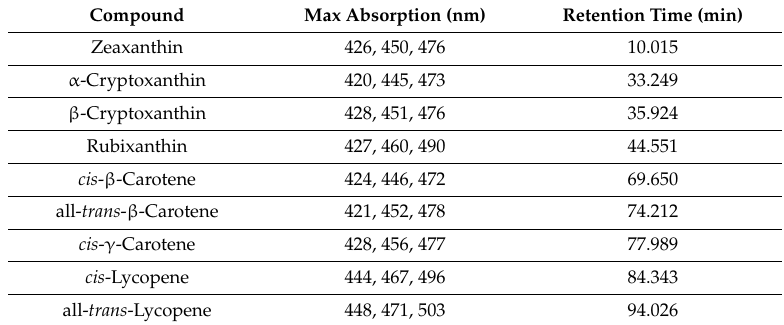
Table 6. Carotenoids used as standards in RP-HPLC analysis and their retention